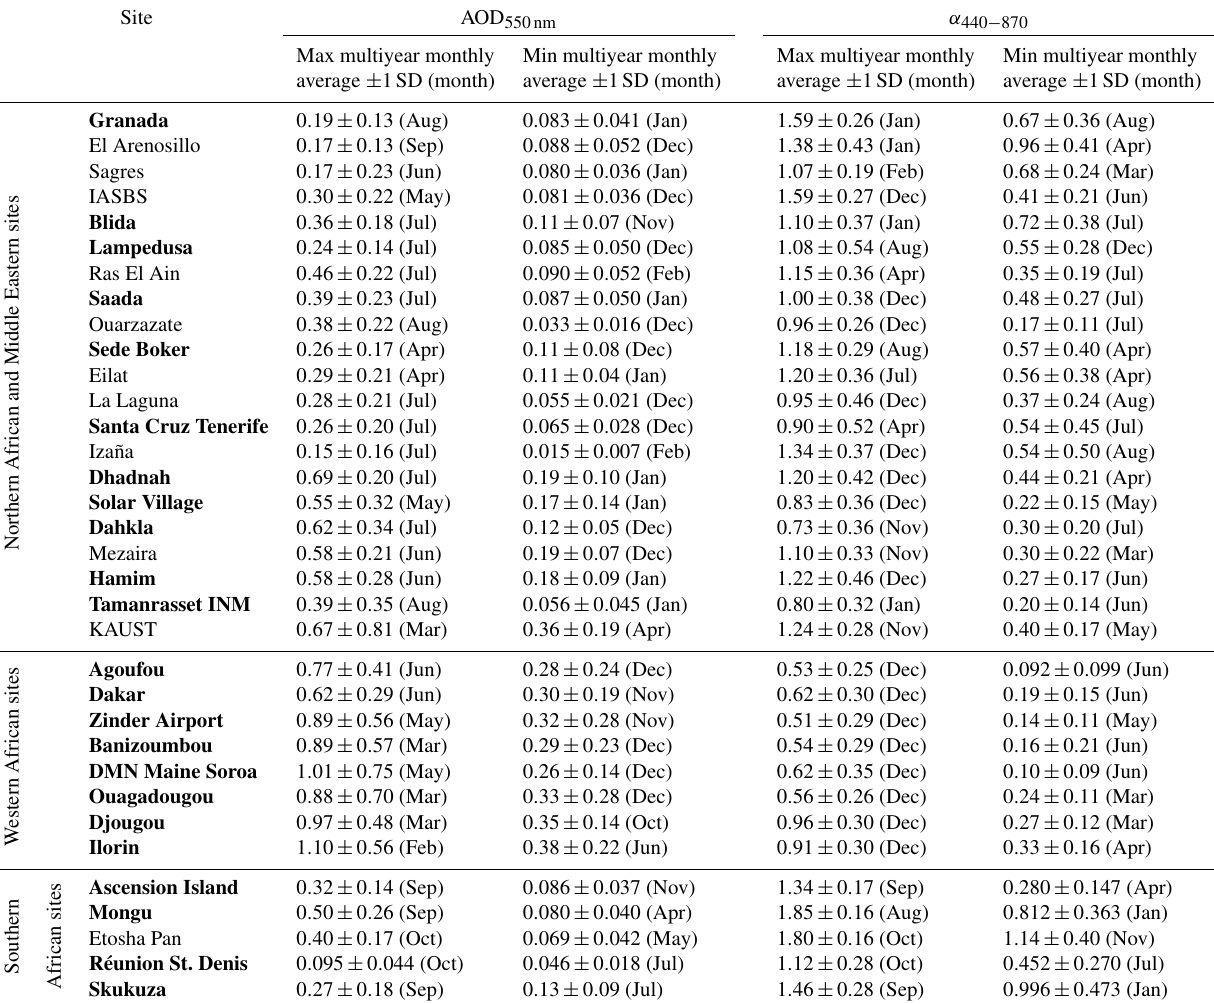
Table 2. Maximum and minimum multiyear monthly averages of AERONET AOD 550nm and α ext ( 440 / 870 ) per site. The month of the reported maximum or minimum value is indicated in parenthesis. Site names in bold font are used in model